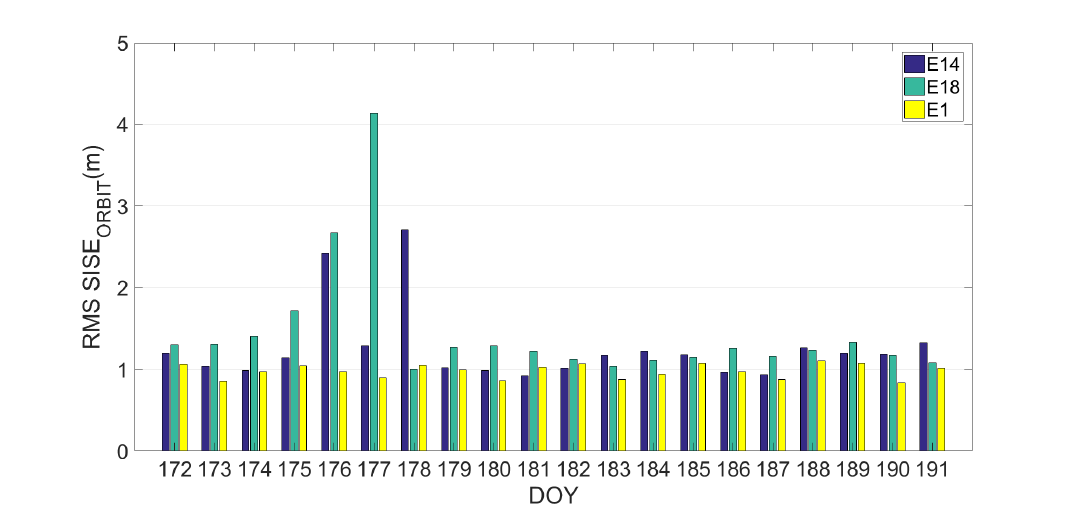
Figure 9. Daily RMS SISE orbit calculated on the dataset of DOY 172–191 for satellite 1 (E1), Milena (E14) and Doresa (E18) satellites reported in yellow, blue and green